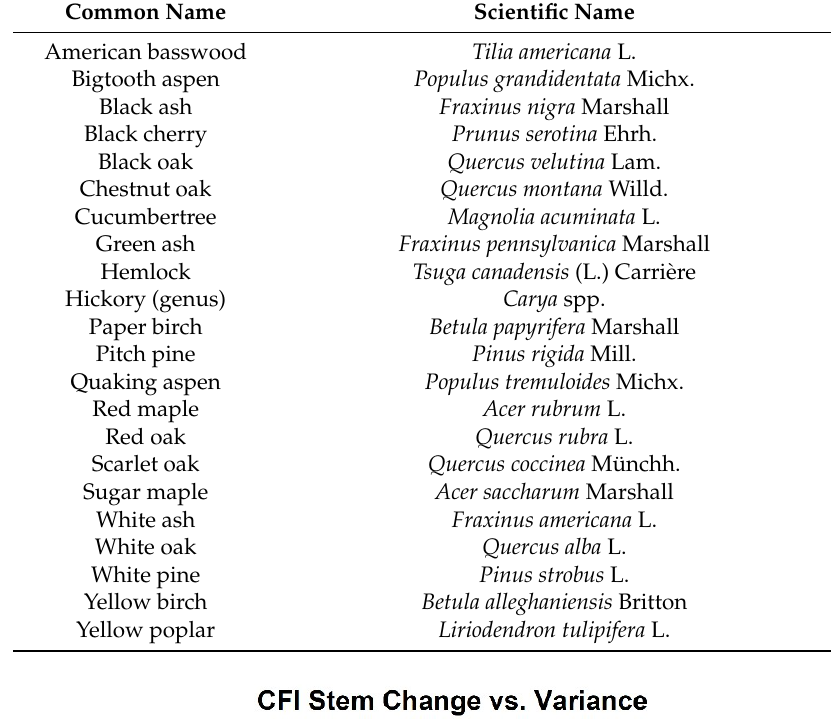
Table A1. List of tree seedling taxa considered desirable regeneration by the Department of Conservation and Natural Resources Bureau of Forestry, of which nearly all species were browse- preferred by white-tailed deer.